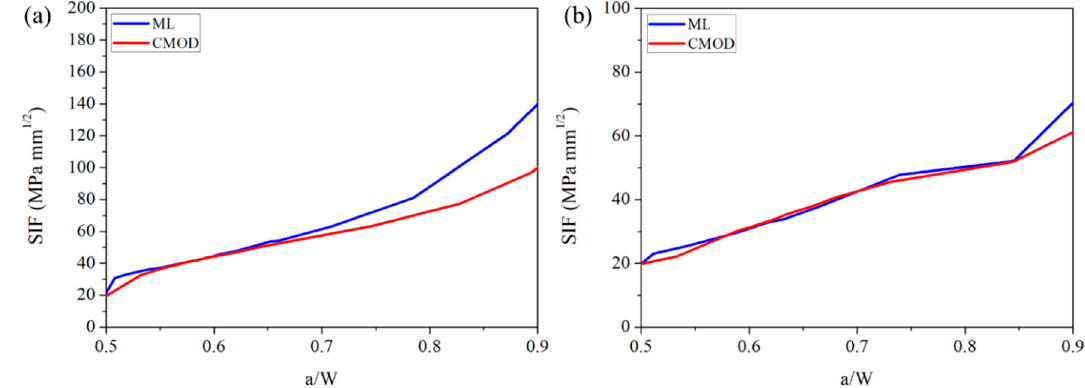
Figure 8. Comparison of SIFs that were obtained from an indirect method (CMOD) and by using ML technology, where ( a ) shows the SIFs of AC and ( b ) shows the SIFs of MC.